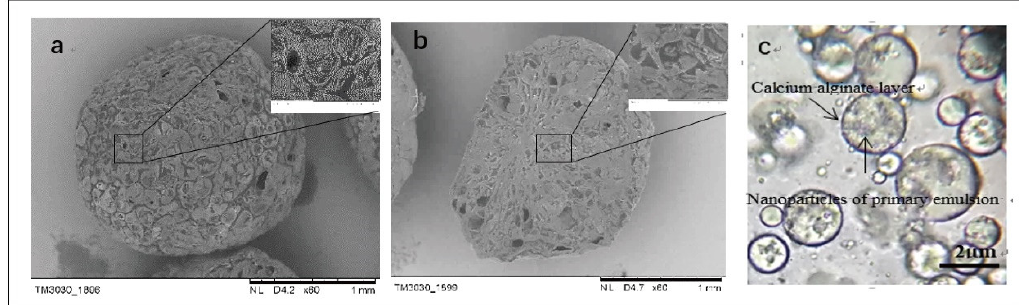
Figure 8. Scanning electron microscope (SEM) images of surface morphology ( a ) capsule, ( b ) the cross-section of capsule, and ( c ) optical microscope image of W/O/W multiple emulsion.